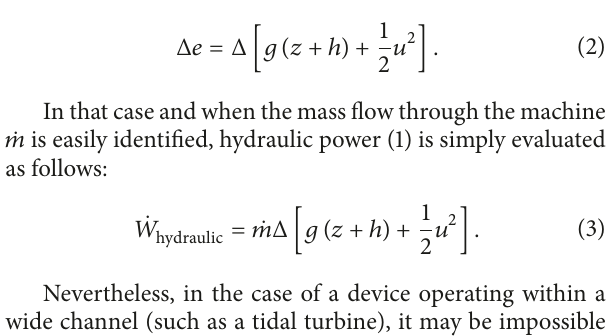
Figure 2: A conceptual representation of the energy flow through a machine operating in arbitrary conditions. The usable power is maximized when the three efficiencies 𝜂 are equal to one. The definition of what constitutes the maximum value of ∫ Δ𝑒 d ̇𝑚 depends on the operating constraints, as discussed